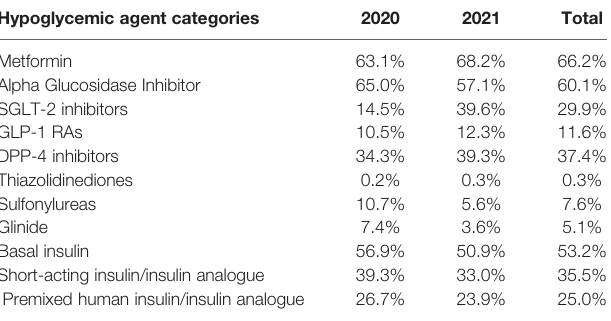
TABLE 3 | Application rates of different categories of hypoglycemic agents of inpatients with type 2 diabetes. Hypoglycemic agent categories